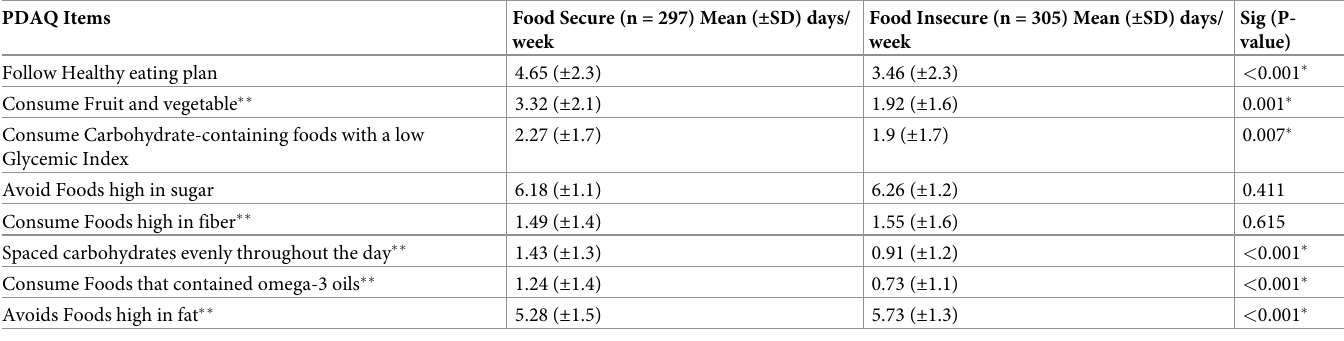
Table 3. Independent samples t-test for mean adherence to dietary counselling score of the food secure and food insecure patients with